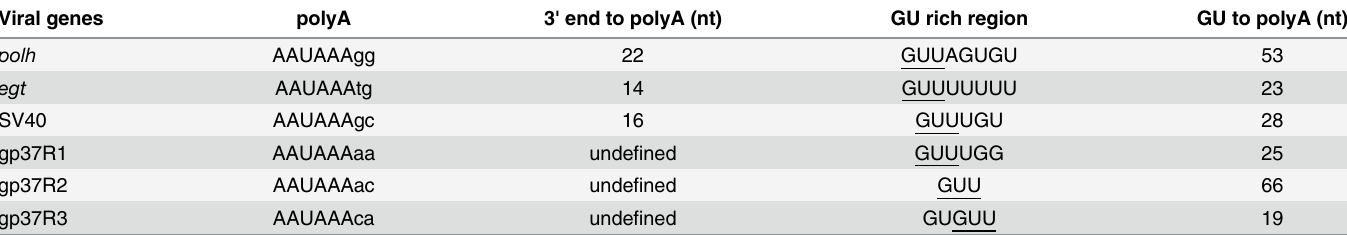
Table 1. Comparison of polyadenylation signals of AcMNPV late gene 3 ’ UTRs with SV40 polyA. Viral